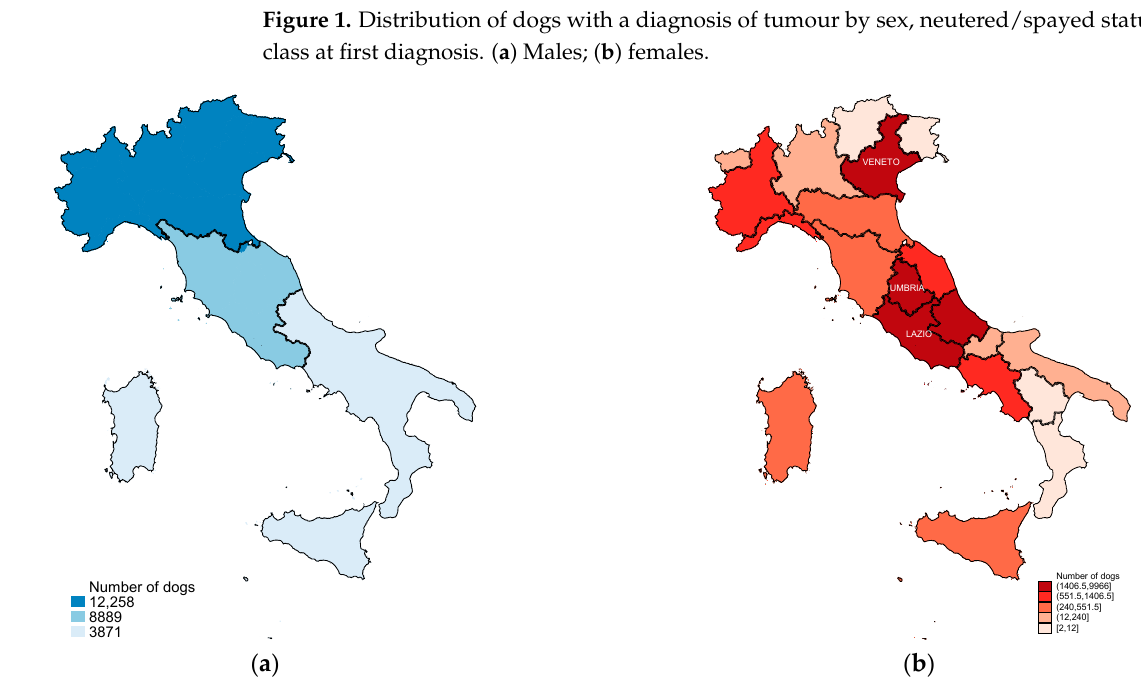
Figure 2. Choropleth maps showing the number of dogs included in the study. The gradient of colour is proportional to the frequency of observations: the darker the colour, the higher the frequency. ( a ) Absolute number of dogs with a diagnosis of tumour by macroregion of residency of the owner (North, Centre, South and Islands), ( b ) number of dogs with a diagnosis of tumour by Italian region, classes follow a quantile distribution, with regions grouped in 5 quintiles, with 4 Regions each. “()“ = excluded; “[]” = included.